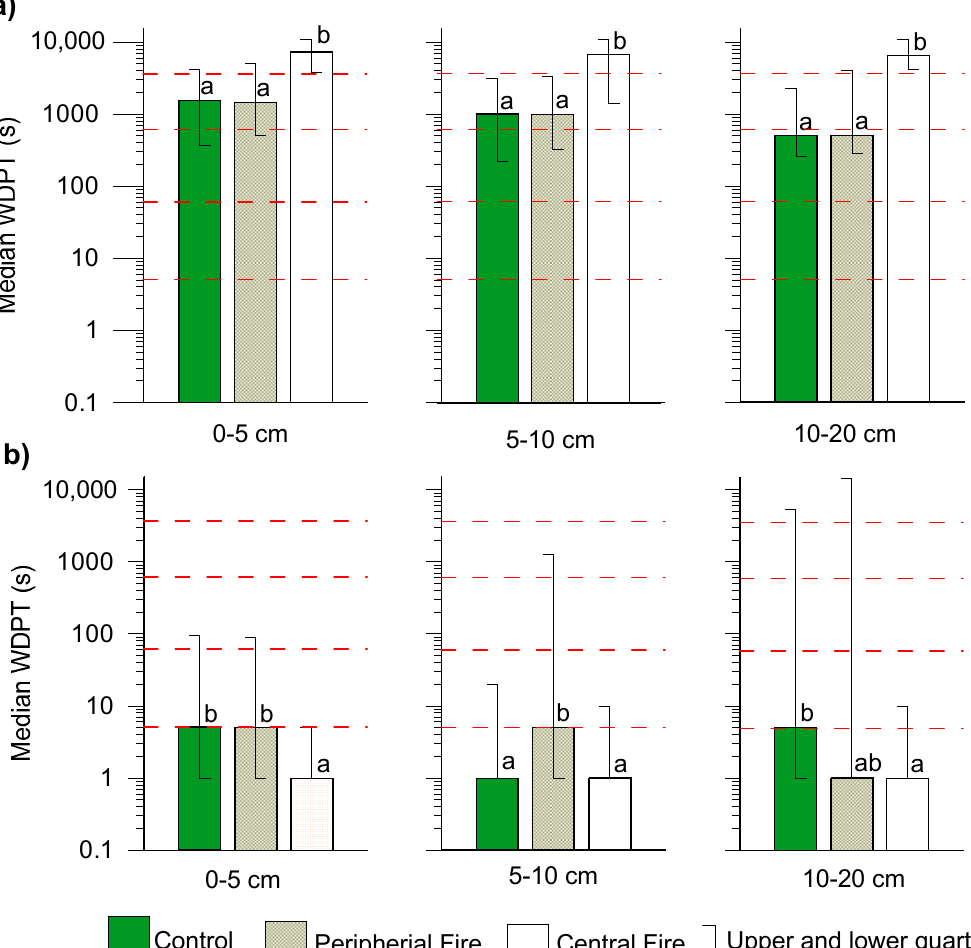
Figure 2. Median Water Drop Penetration Time (WDPT) with upper and lower quartiles on the control site, and in the areas of a peripheral fire and central fire in three soil depths ( a ) 1 month after a fire; ( b ) 13 months after a fire. Note: Different letters denote significant differences in each depth, as determined with the Kruskal-Wallis test ( α < 0.05). SWR classes (red dashed lines), (0) wettable or non-water repellent, WDPT < 5 s; (1) slightly repellent, from 5s WDPT ≤ 60 s; (2) strongly repellent, from 60s WDPT ≤ 600 s; (3) severely repellent, from 600s WDPT ≤ 3600 s; and (4) extremely repellent, WDPT > 3600 s.